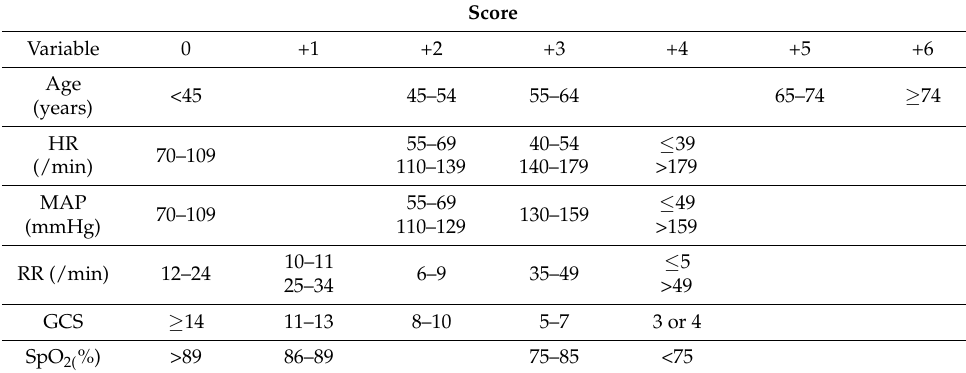
Table 3. Rapid Emergency Medicine Score (REMS) [23].